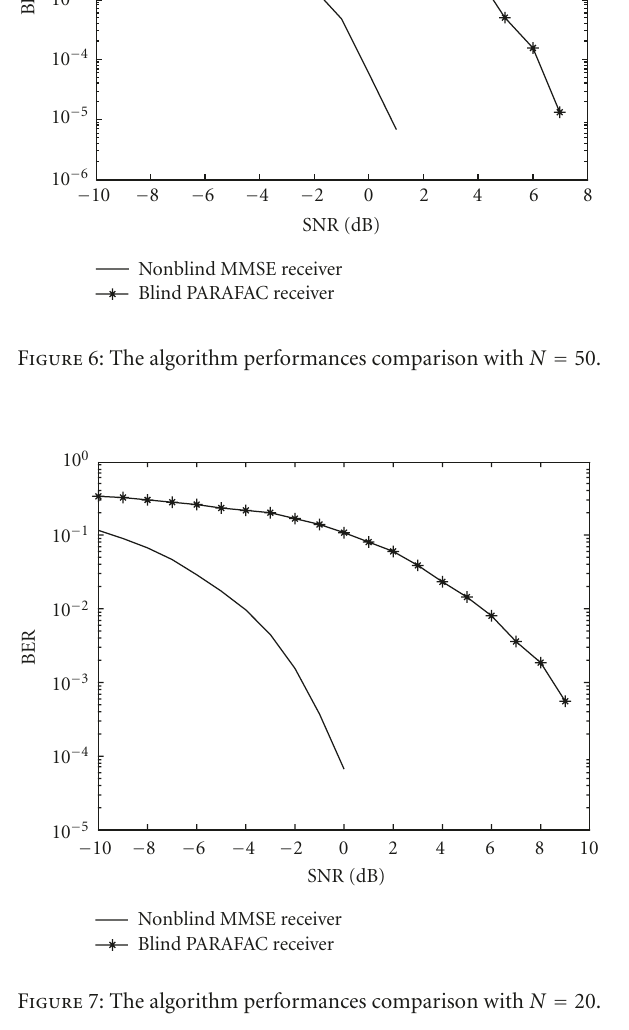
performance in the array error condition. Blind PARAFAC signal detection algorithm has robust characteristics to array error.